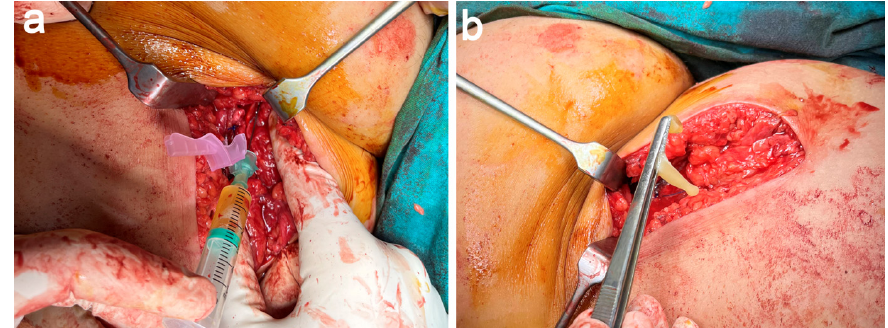
Figure 6. Application of PRGF. ( a ) Intratendinous infiltration of PRGF into the allograft suture-repair areas. ( b ) The sciatic nerve is wrapped with a PRGF membrane.